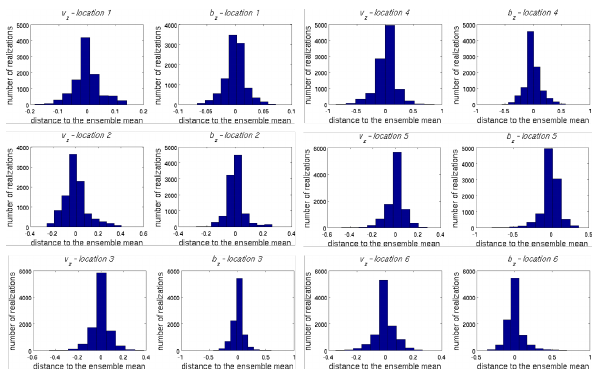
Fig. 3. Distribution of the forecast errors for the z component of the Figure 3. Distribution of the forecast errors for the z component of the solar wind velocity and 3 solar wind velocity and magnetic field at the different test locations magnetic field at the different test locations illustrated in figure 1: location 1 (source surface), 4 illustrated in Fig. 1: location 1 (source surface), location 2, location location 2, location 3, location 4 (Lagrange point, L1), location 5 and location 6. The errors are 5 3, location 4 (Lagrange point, L1), location 5 and location 6. The calculated from the dispersion of the perturbed ensemble member trajectories around the 6 errors are calculated from the dispersion of the perturbed ensemble ensemble average. 7 member trajectories around the ensemble average.